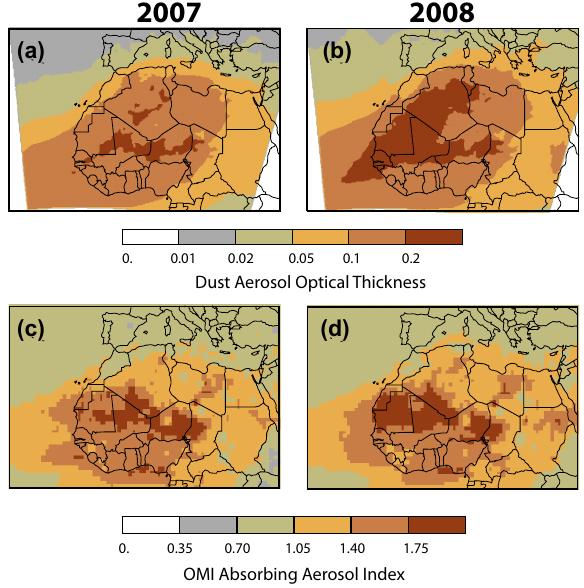
Fig. 4. Annual averaged dust optical thickness for the years 2007 (left panels) and 2008 (right panels) computed with COSMO- MUSCAT (a, b) ; annual averaged absorbing aerosol index from the OMI satellite instrument (c, d)